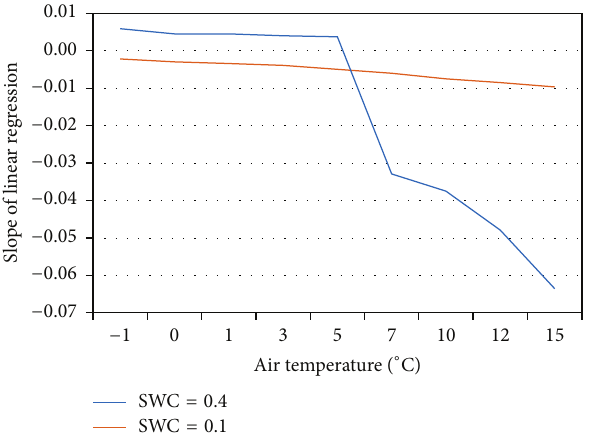
Figure 5: Slope of linear regression for ET and LST with nine scenarios of air temperature and two scenarios of soil water content.